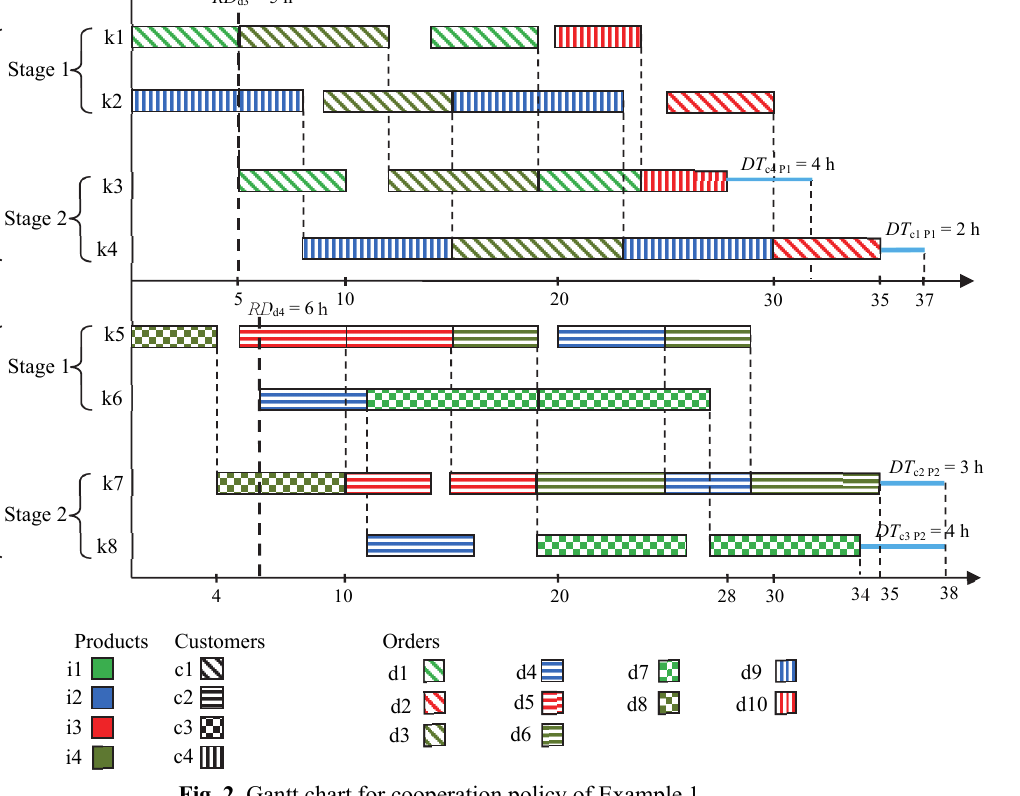
Fig. 2. Gantt chart for cooperation policy of Example 1.